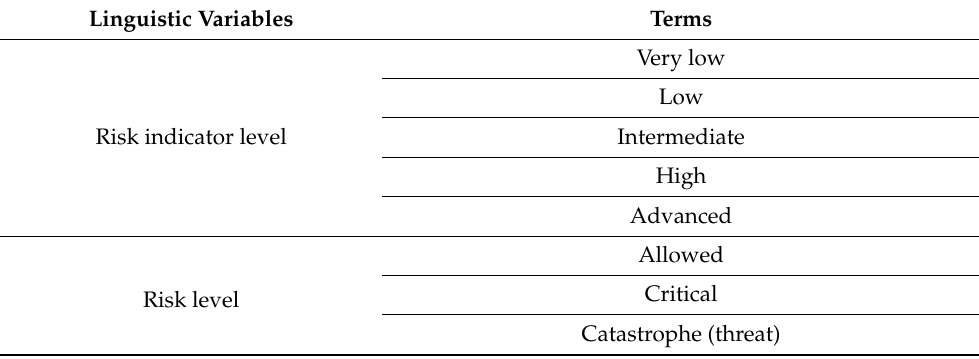
Table 2. Linguistic variables and term-varieties (the author’s